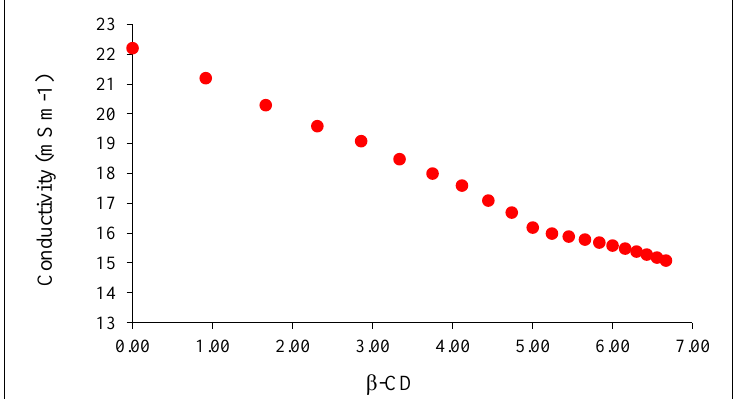
Figure 7. Variation of conductivity of aqueous PNB solution with increasing concentration β-CD at 298.15K.